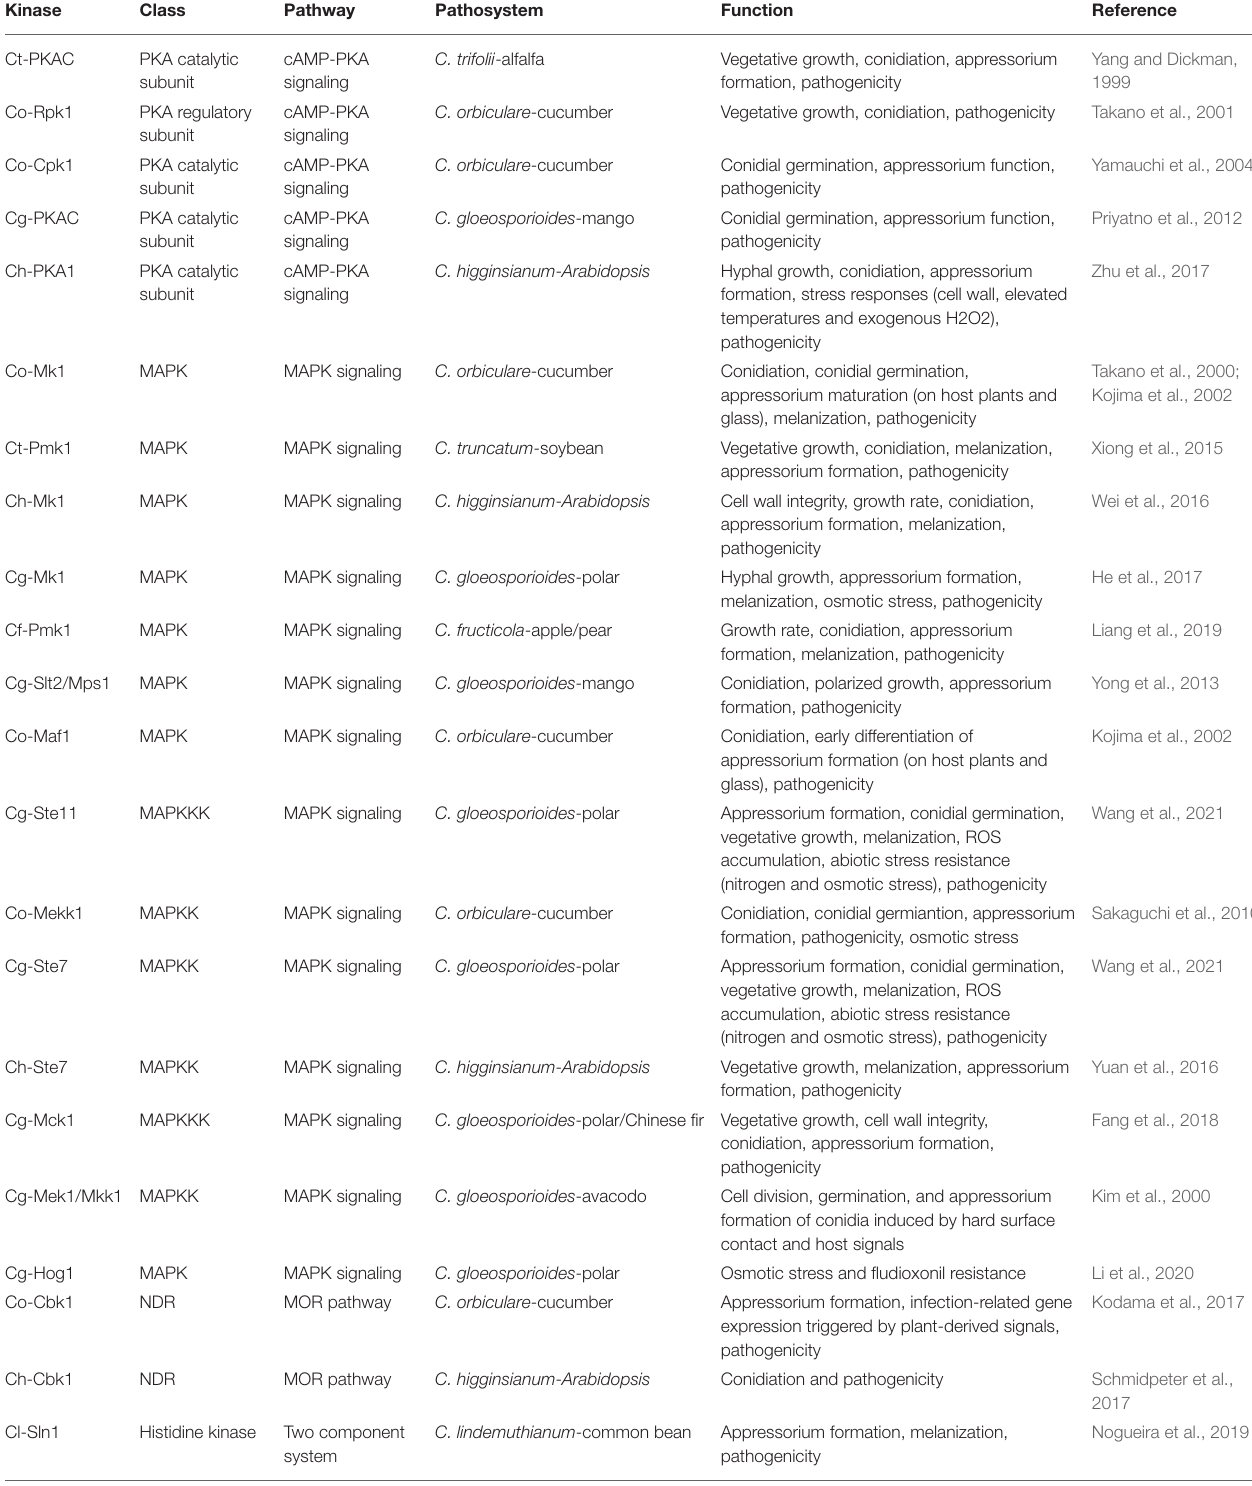
TABLE 3 | Summary of protein kinases regulating morphogenesis and pathogenesis of Colletotrichum .